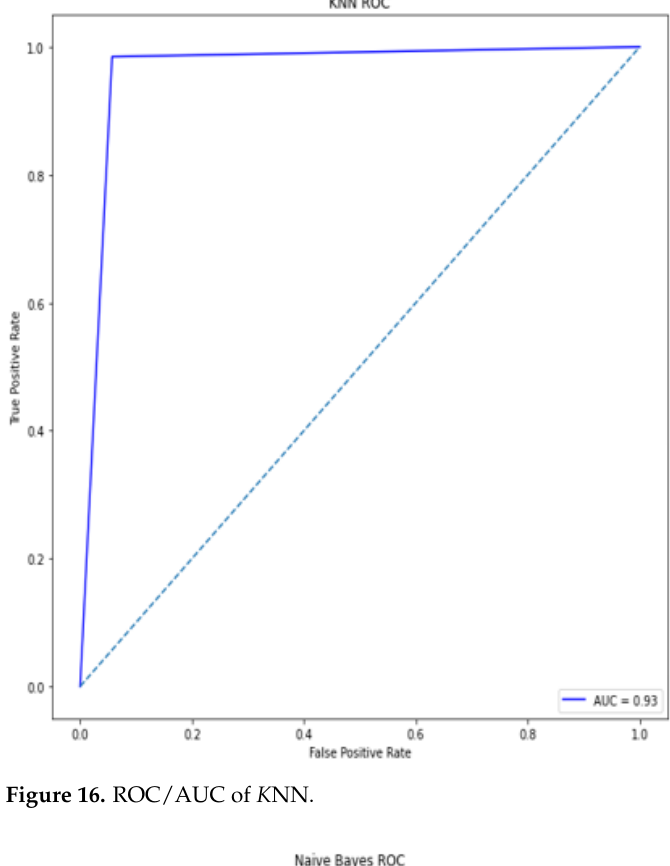
Figure 15. ROC/AUC of SVM.